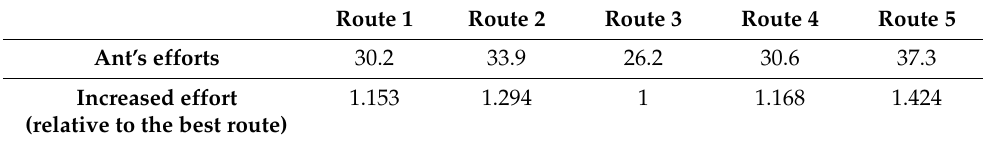
Table 7. Summary of